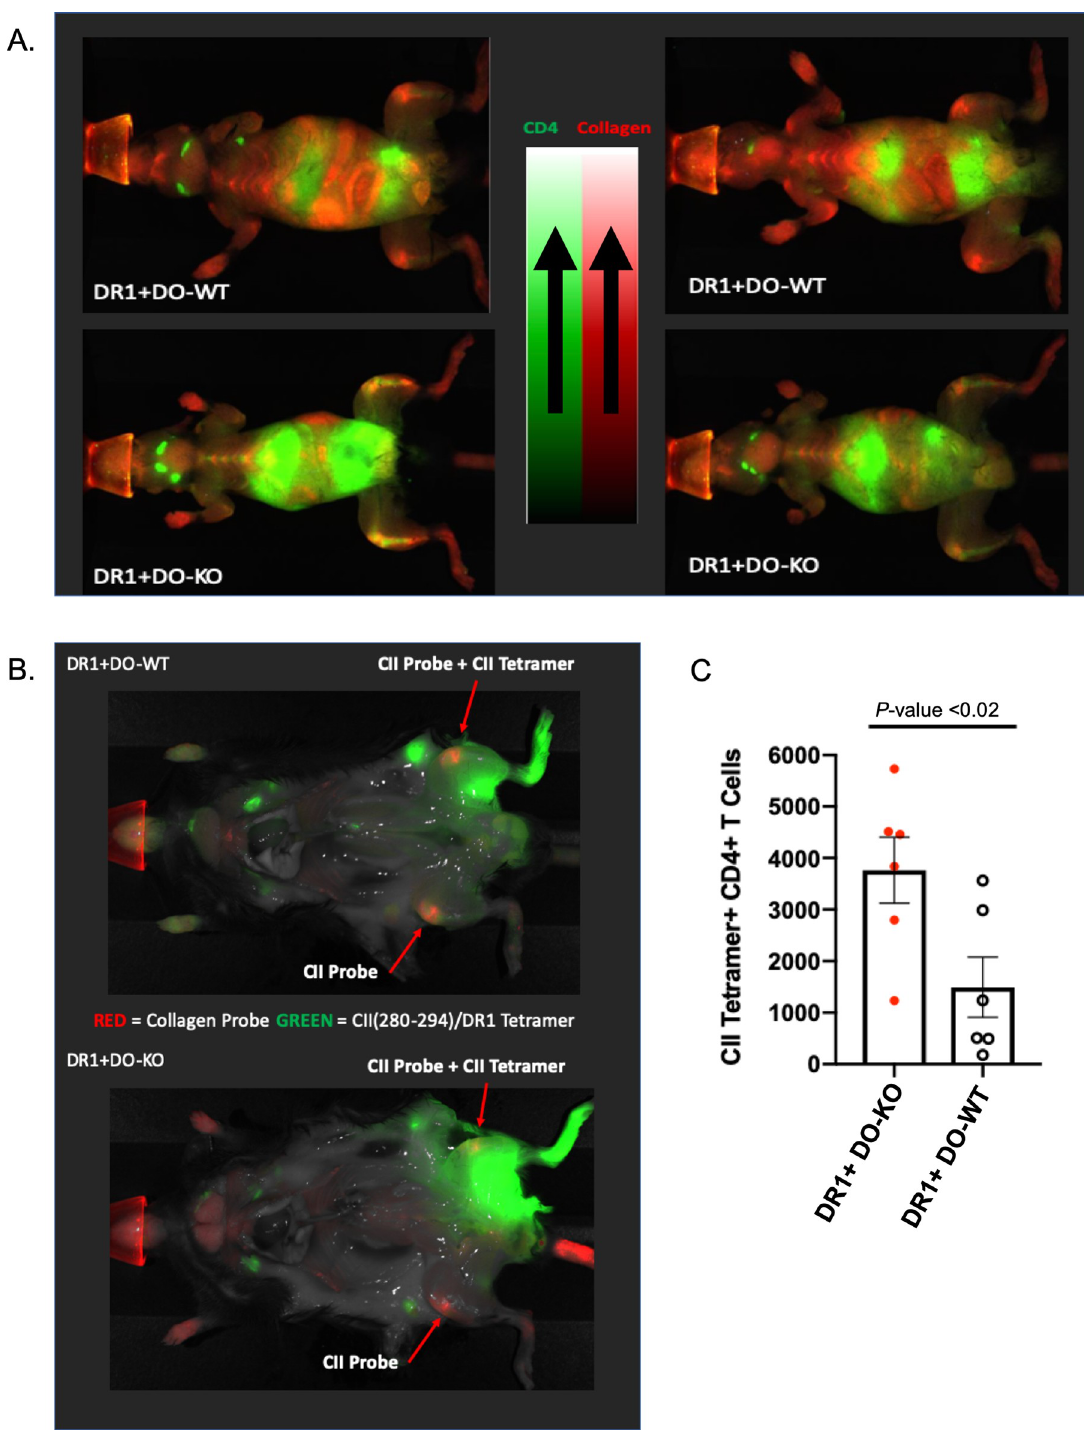
Fig 5. CIA diseased DR1 + DO-KO mice showed increased co-localization of CII(280–294)/DR1 tetramer positive CD4 T cells with denatured collagen. (A) Representative images showing whole-body NIRF imaging of CMP probe (red) injected (IV) followed by CD4 probe injected IP (green) 48 hours prior to imaging. Co-localization of denatured collagen with CD4 infiltration is denoted by orange signal. Representative of 3 independent experiments. (B) Representative images of CIA diseased DR1 + DO-KO (top) and DR1 + DO-WT (bottom) mice showing the distribution of in vivo stained CII(280–294)/DR1 tetramer positive T cells (green) 72 hours after footpad injection. CMP probe (red) was injected IV at the same time. Representative of 2 independent experiments. (C) Increased number of in